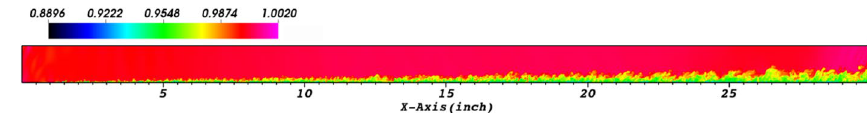
Fig. 1 Instantaneous density contour at z